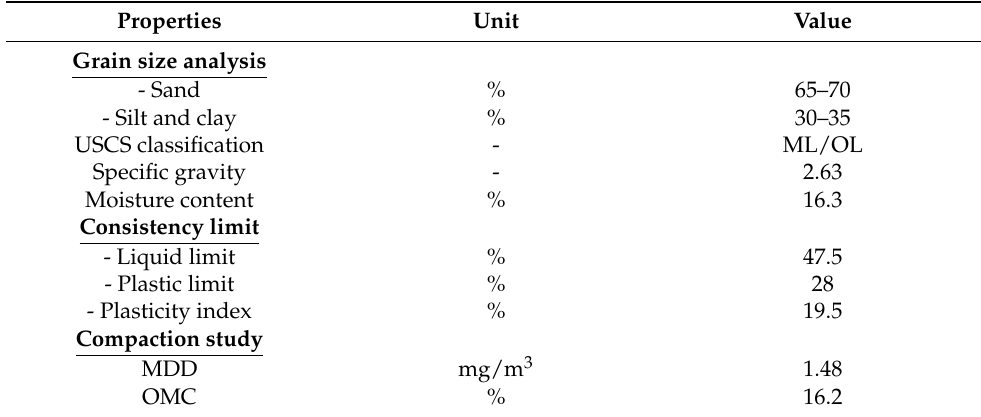
Table 1. Physical properties of West Coast Malaysia coastal